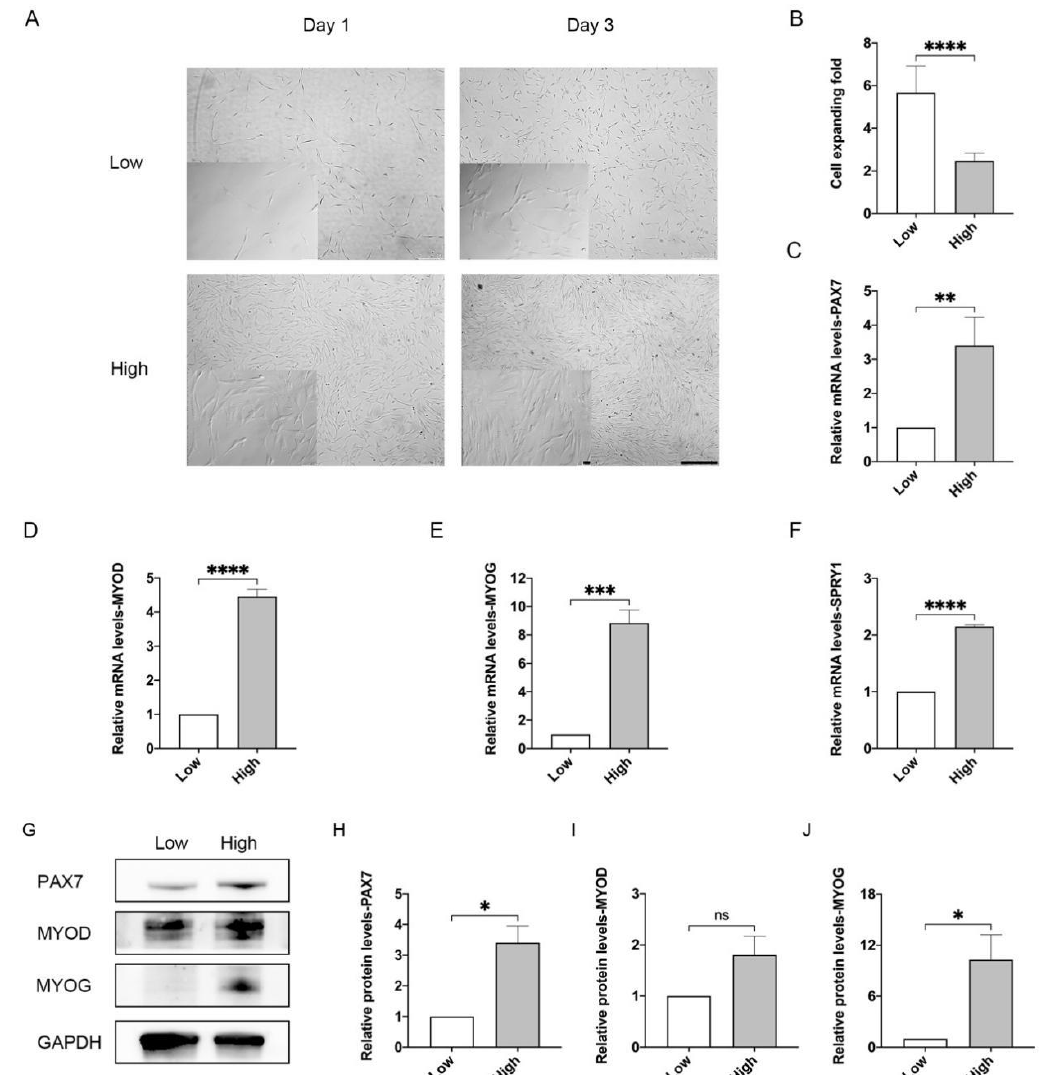
Figure 1. Defective proliferation and differentiation in MuSCs cultured under high-density condition. MuSCs were plated at densities of 2.7 × 10 3 /cm 2 (low density) and 2.2 × 10 4 /cm 2 (high density) at day 0. ( A ) Microscopic images of porcine MuSCs cultured in low or high conditions under bright field after one or three days post seeding. Scale bar, 100 μm. ( B ) Cell expanding fold when harvested after three days of culture. ( C – F ) Expression by qPCR of PAX7 , MYOD , MYOG, and SPRY1 in MuSCs under low and high-density conditions. ( G ) Western blot analysis of PAX7, MYOD, MYOG in MuSCs. ( H – J ) Relative protein levels of PAX7, MYOD, and MYOG normalized to GAPDH indicated in ( G ) by Quantity One software. Mean ± SD from three independent experiments. Significance was analyzed by Students’ t -test, * p < 0.05, ** p < 0.01, *** p < 0.001, **** p < 0.0001, ns, not significant ( p > 0.05).